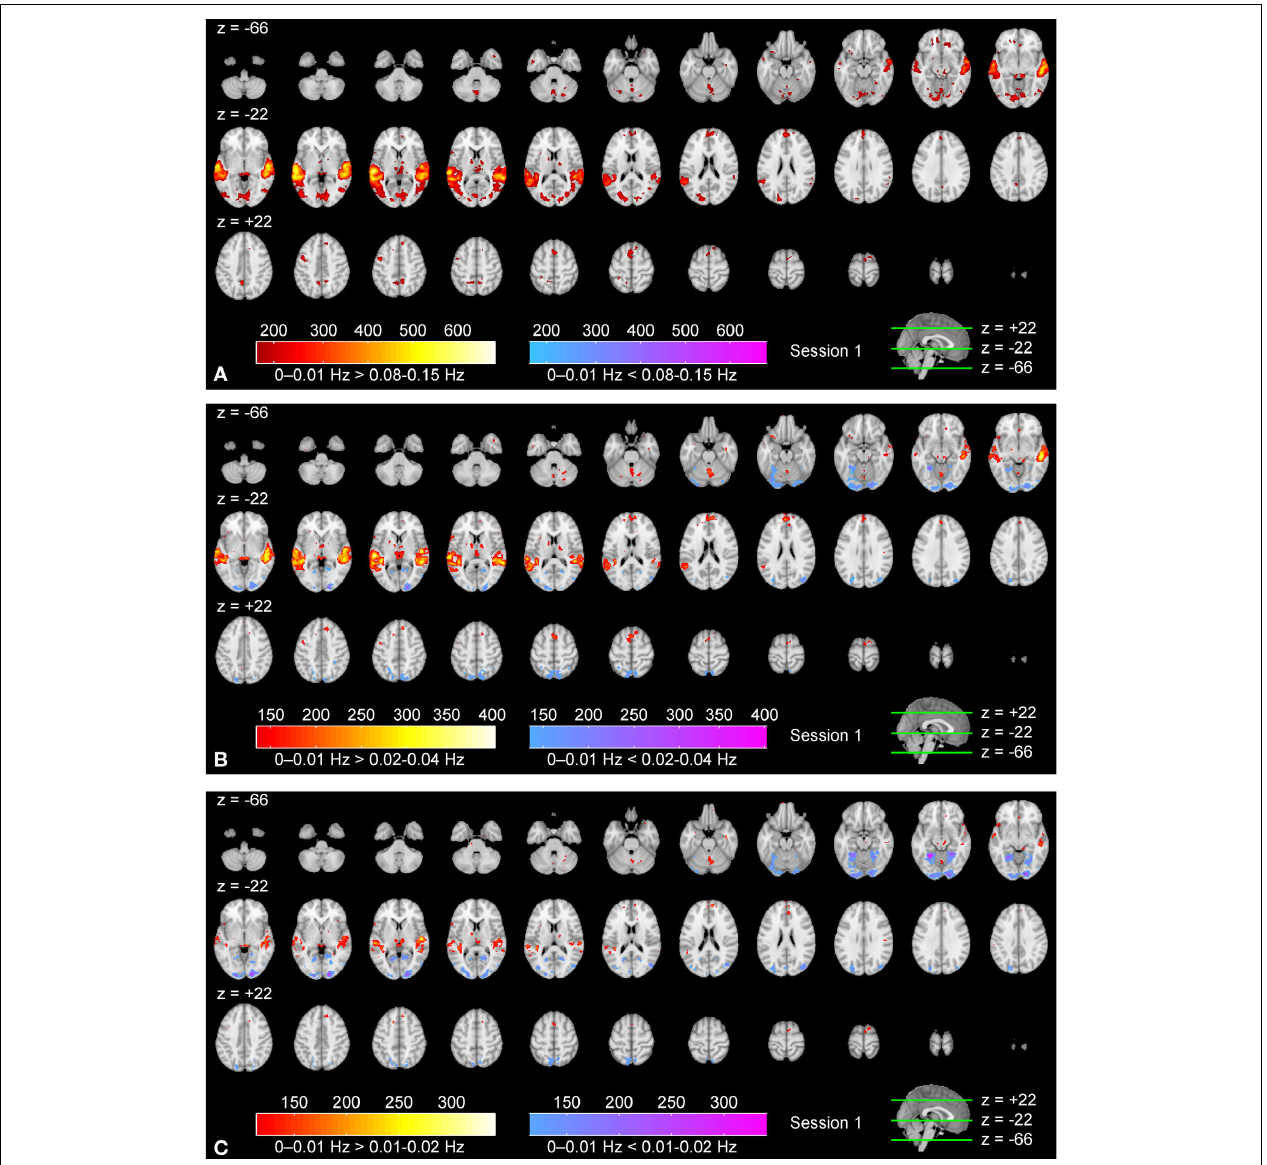
FIGURE 5 | Sum ZPF statistical maps ( p < 0.05, FWER corrected) of the lowest frequency band (0–0.01 Hz) compared with the (A) 0.07–0.15 Hz band, (B) 0.02–0.04 Hz, and (C) 0.01–0.02 Hz band. From top left to bottom right, axial slices from z = − 66 to 62 mm (in MNI-coordinates) with 4 mm